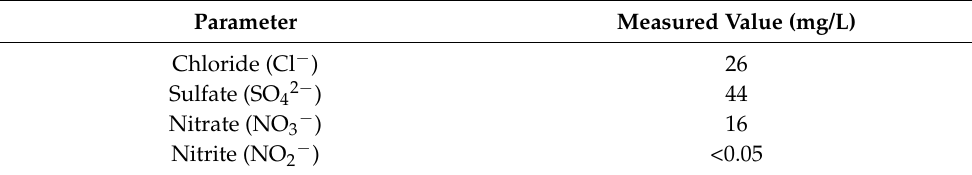
Table 1. Concentration values of different anions in tap